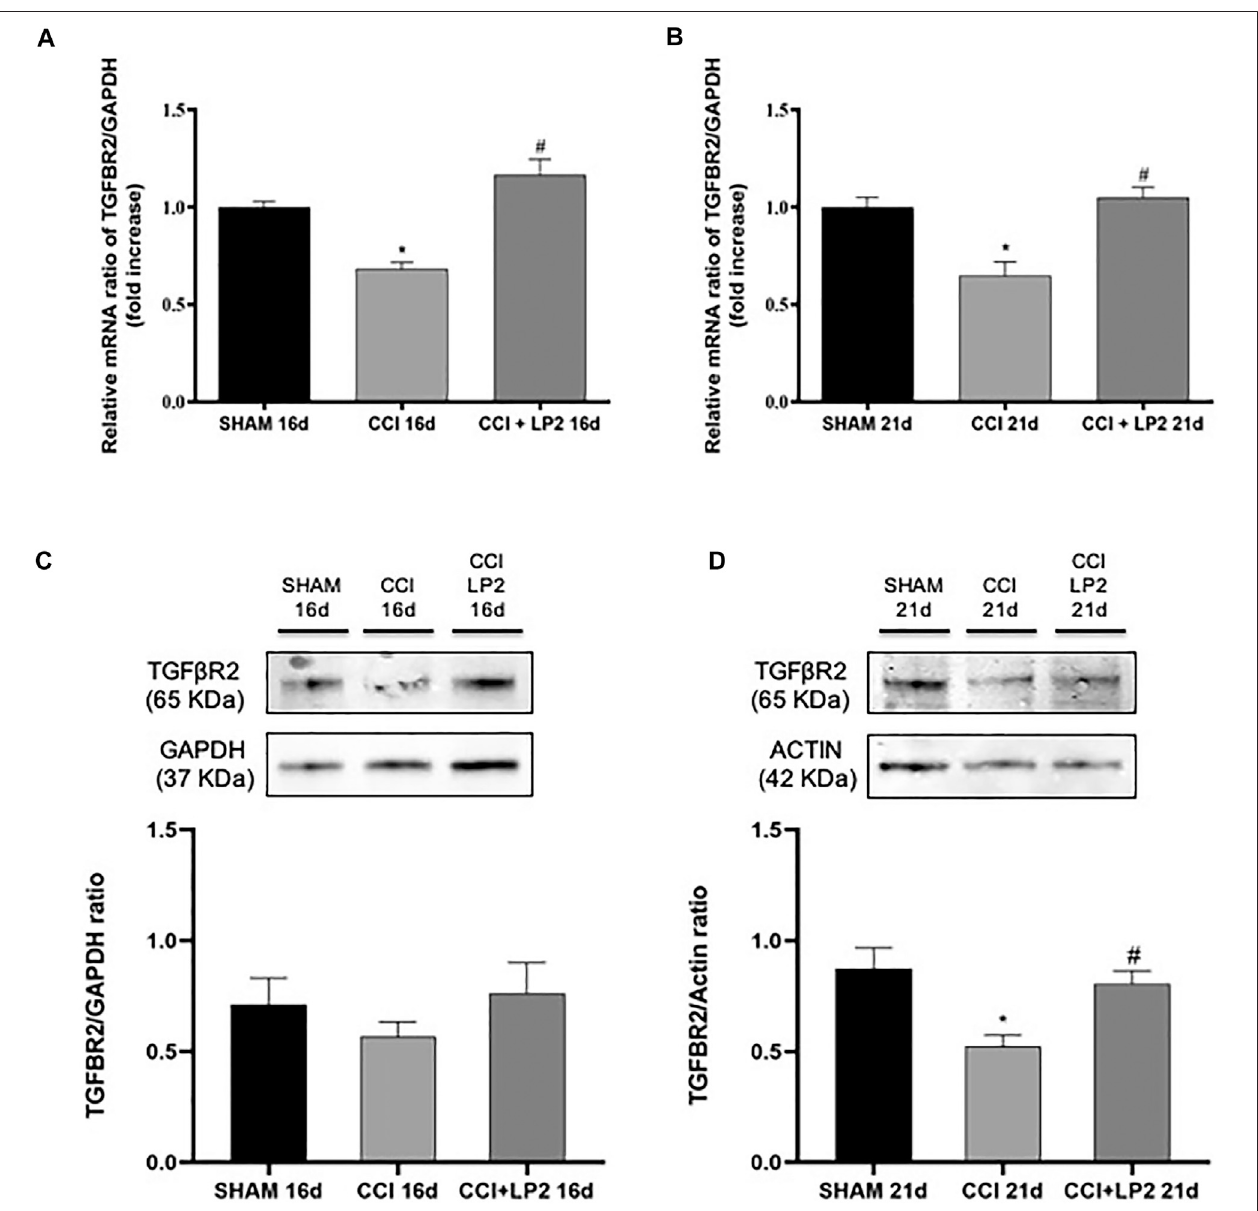
FIGURE4| CCIinducesareductionofTGF β -R2mRNAandproteinexpressionlevelsreversedbyachronictreatmentwithLP2.EffectsinducedbyCCIprocedure intheabsenceorpresenceofLP2treatmentat16and21dplonTGF β -R2levelsevaluatedbyRT-qPCRandwesternblotanalysis. (A – B) TheabundanceofeachmRNA ofinterestwasexpressedrelativetotheabundanceofGAPDHmRNA,asaninternalcontrol.Dataareshownasmean ± SEMof n (cid:1) 3ratspergroup.TGF β -R216 days[F (2,7) (cid:1) 22,66];TGF β -R221 days[F(2,5) (cid:1) 13,51]. (C – D) RepresentativeimmunoblotsofTGF β -R2(65 kDa)intotalproteinextractsfromspinalcordtissuesat16[F (2, 12) (cid:1) 0,8078] and 21 [F (2, 12) (cid:1) 7,197] dpl. Histograms refer to independent experiments means ± SEM of the TGF β -R2 densitometric values normalized against GAPDH and actin used as internal controls by one-way ANOVA with Bonferroni ’ s post-hoc for statistical analysis. Data are shown as mean ± SEM of n (cid:1) 4 – 6 rats per group. * p < 0.05 vs. SHAM, # p < 0.05 vs.